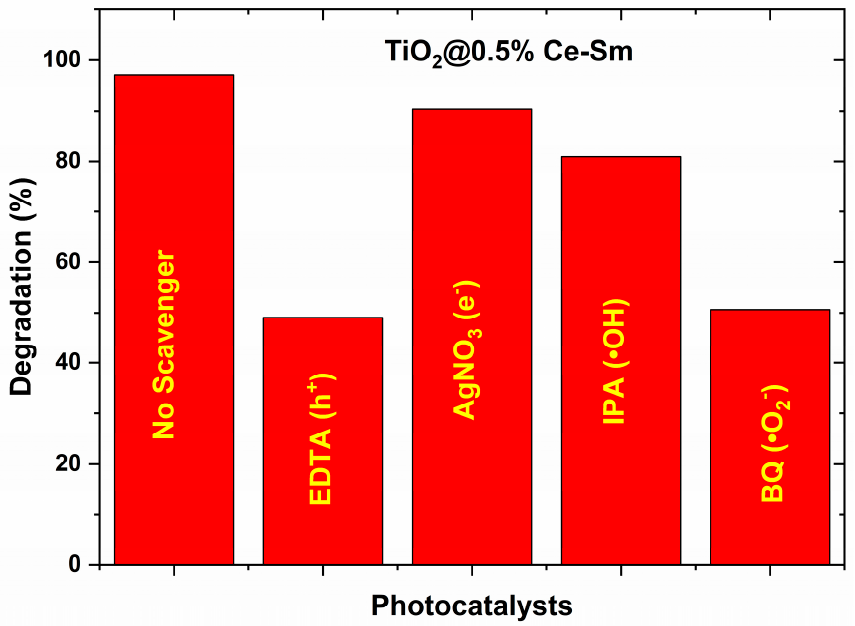
Figure 13. Recyclability of Ce–Sm co-doped TiO 2 NPs with x = 0.50%.